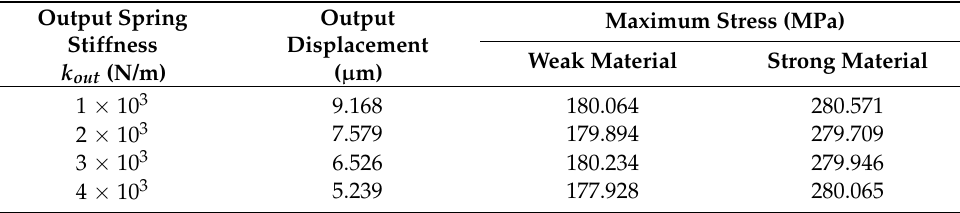
Table 3. Optimal results for compliant gripper under different output spring stiffness.